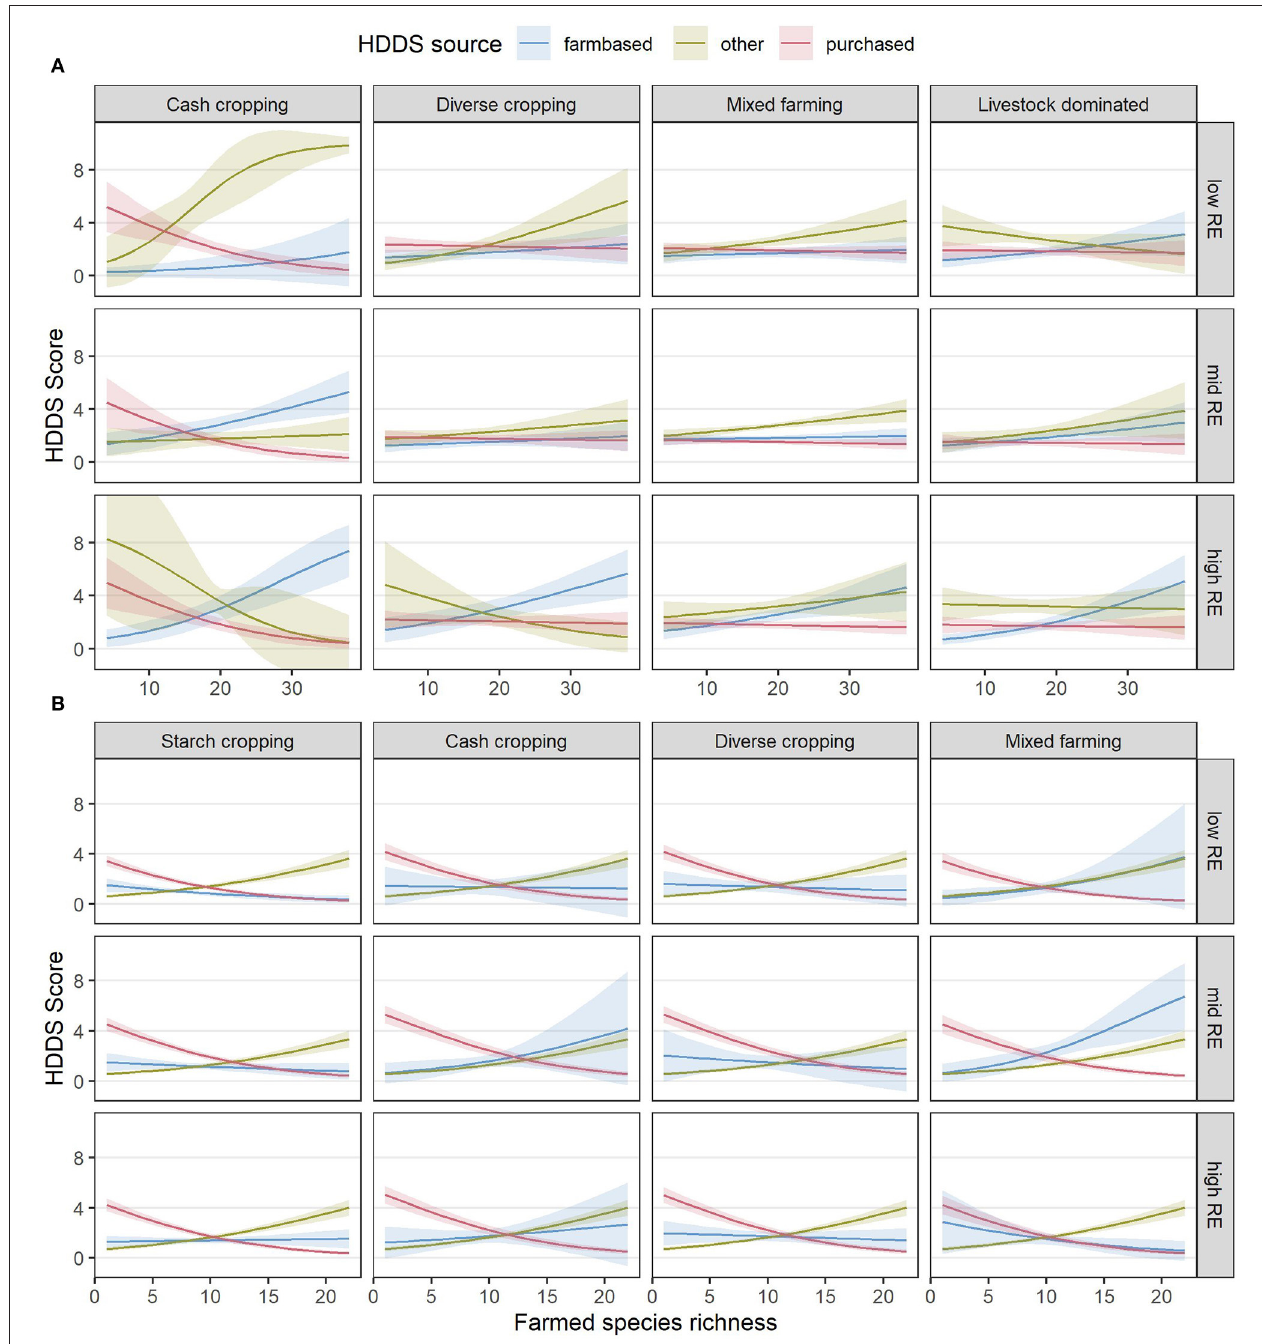
FIGURE 9 | Estimated relationships between diet diversity scores from different sources in Kenya (A) and Nigeria (B) and the combinations of RE groups, FC groups and species richness (SR) derived from the final, reduced models. Lines indicate the estimated mean response, while shaded ribbons indicate 95% confidence intervals for the mean response. Graphs include extrapolation of the estimated relationships beyond the observed ranges of farmed species richness, to enable comparison of the shapes of the responses for different combinations of RE and FC groups, but extrapolated estimates should be interpreted with caution. Estimates are back-transformed from the logit scale on which the models were fitted. Raw datapoints are not shown as there would be three per response (one for each source) leading to an uninterpretable plot; however the distribution of total HDDS can be seen in Figures 6C , 7C